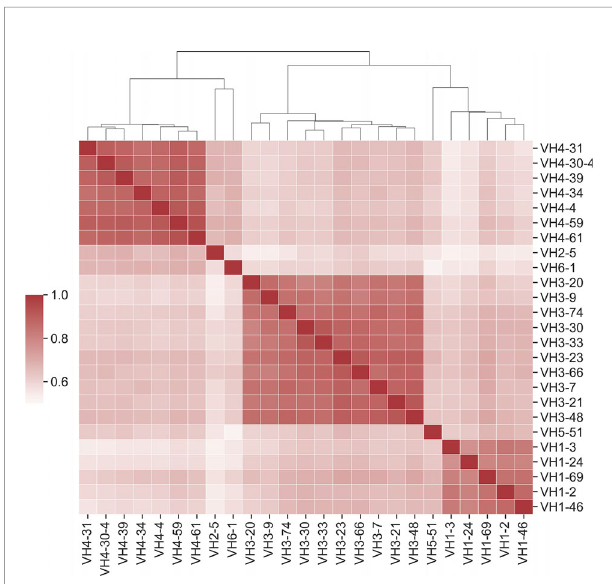
FIGURE 6 | Position-speci fi c framework mutation scores are highly correlated within VH germline gene families. Pearson correlation coef fi cients were calculated for each pair of PSSM scores. Germline families are grouped by hierarchical clustering of Pearson correlation coef fi cients. Dendrogram indicates similarity between germline